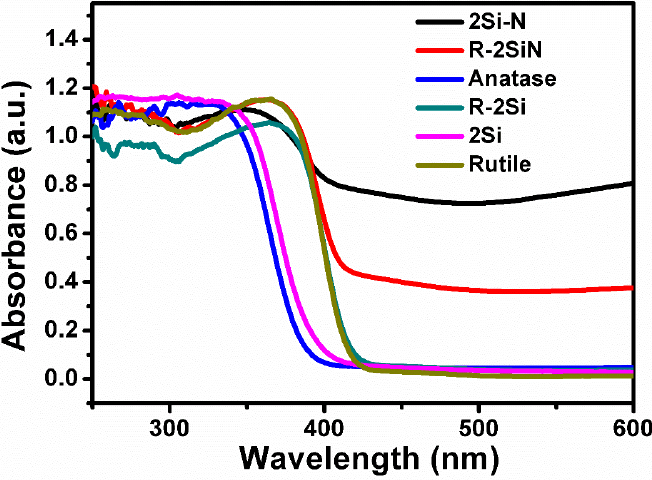
Figure 9. UV-visible diffuse reflectance spectra of the produced samples and comparison with raw anatase and rutile powders.